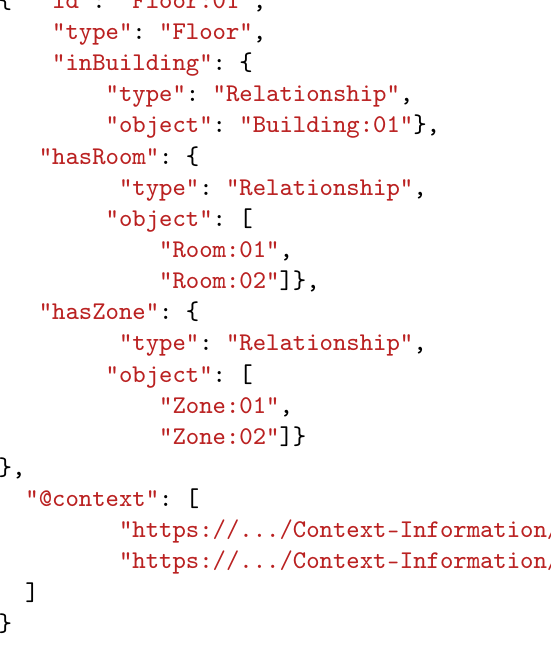
Figure A1. Annotated data of Floor.